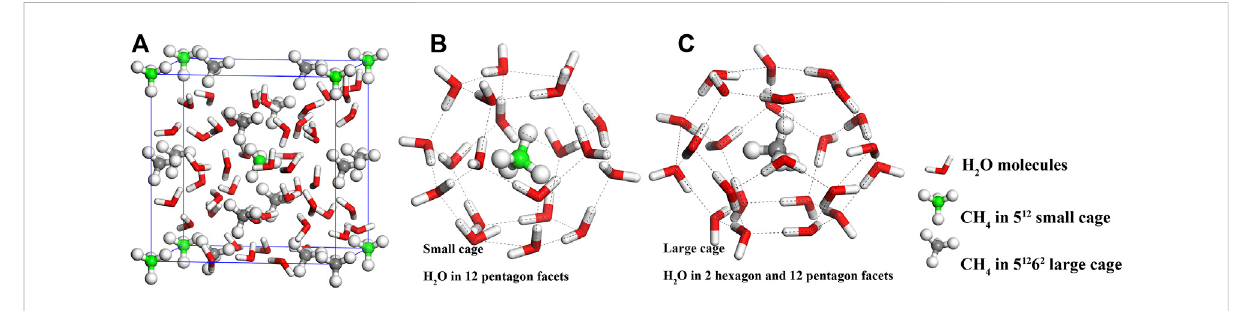
FIGURE 1 Atomic structure of cubic sI-MH (A) . The spheres with white, green (grey), and red colors denote H, C, and O atoms, and C atoms in green and grey depict the carbon atoms of CH 4 in 5 12 small water cage (B) and 5 12 6 2 large water cage (C) , respectively.